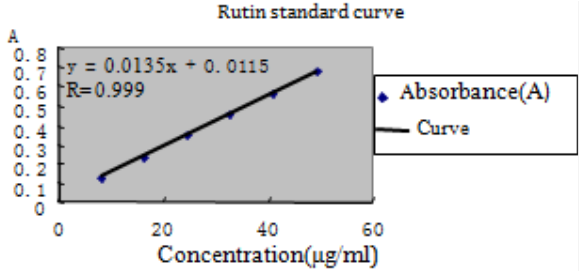
Figure 1: Standard curve of rutin.